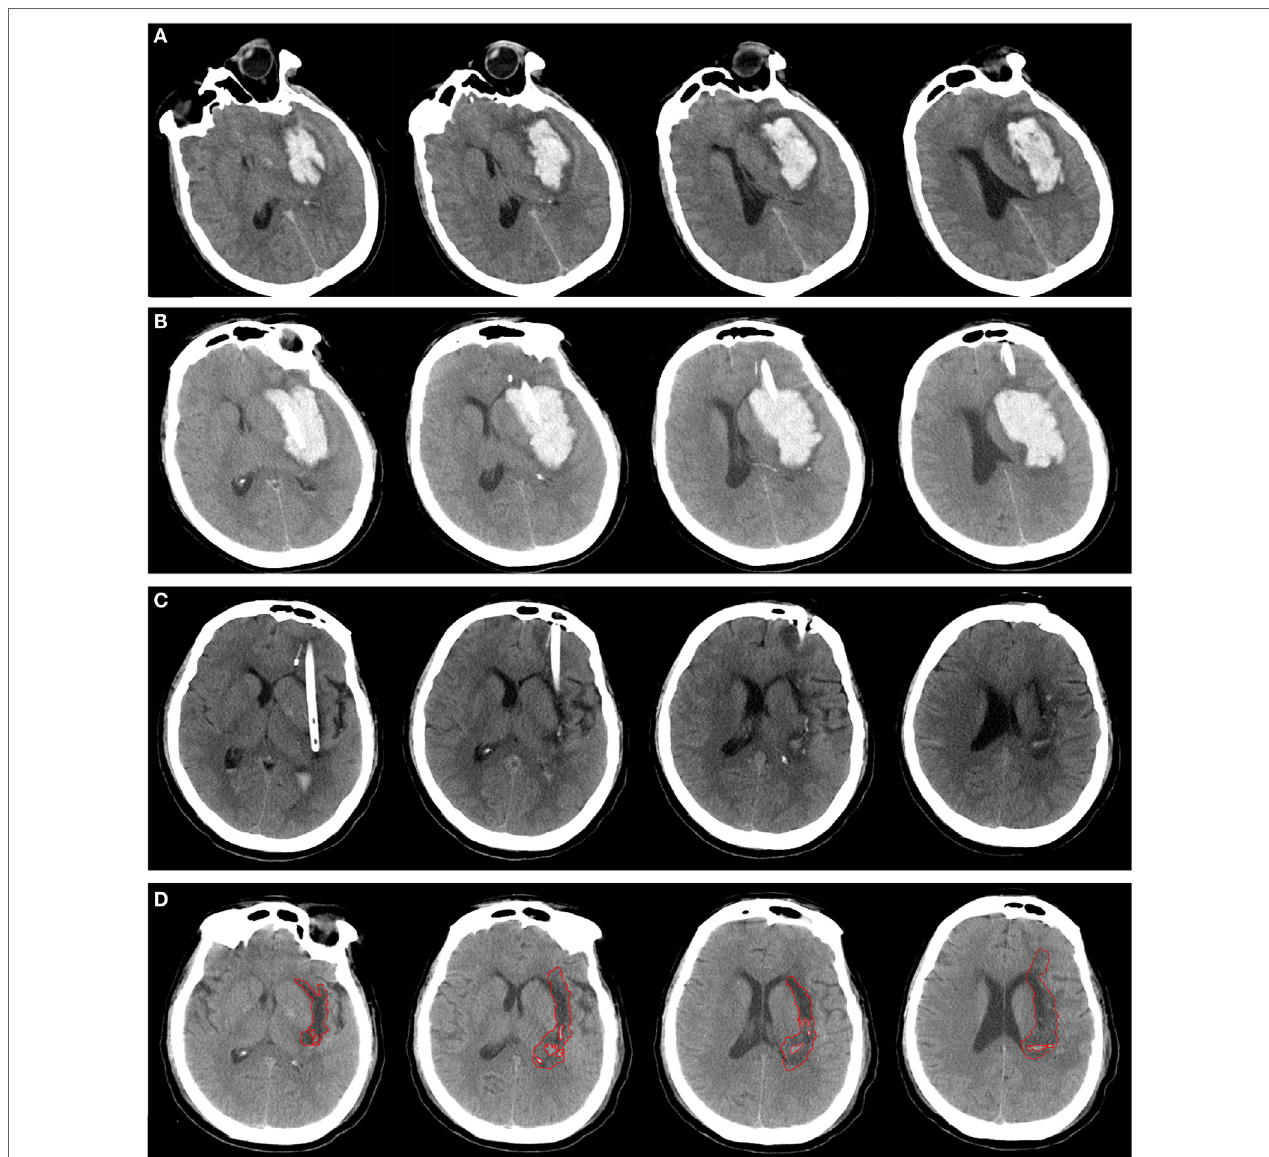
FigUre 1 | A patient with spontaneous intracerebral hemorrhage in basal ganglia received urokinase-type plasminogen activator (uPA) at 24 h postoperatively. Computed tomography scan before operation (a) , at postoperative day 1 (B) , after application of uPA (c) , and postictus day 7 (D) . The perihematomal edema was semiautomatically threshold-based segmentated and outlined with red line (D)